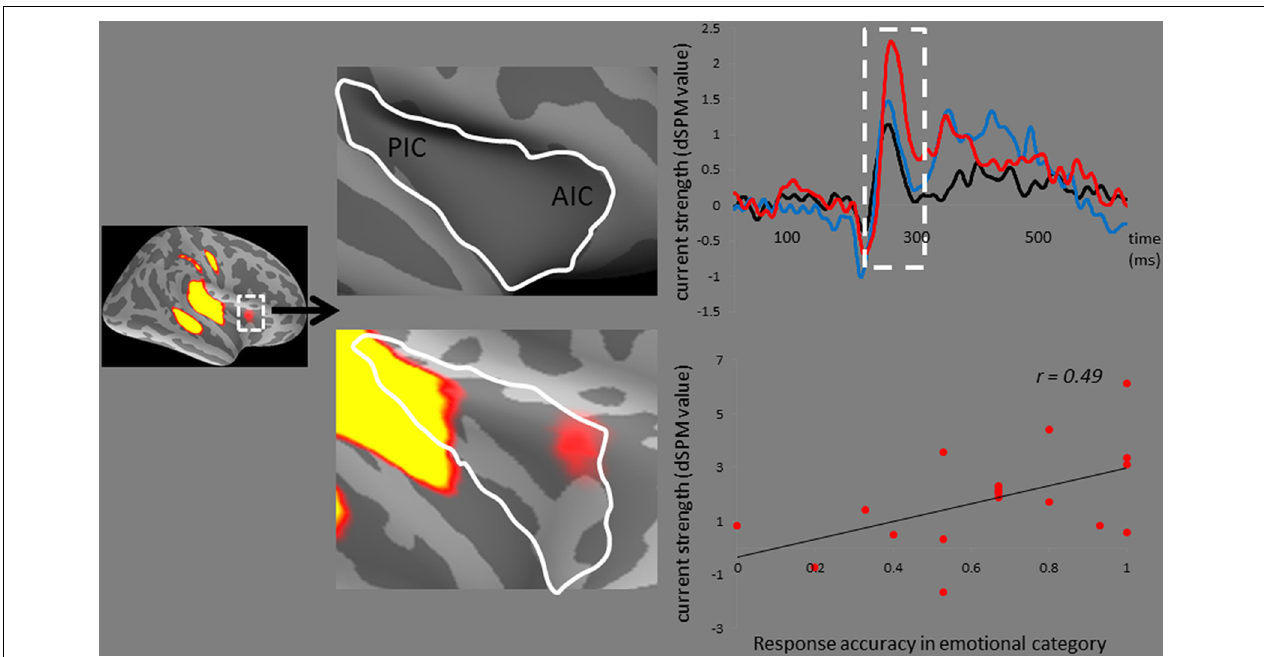
FIGURE 5 | The anterior insular cortex activity in response to disgusted syllables. Disgusted deviants exclusively elicited the activation in the AIC, as indicated by MMNm-related cortical activities. Grand average ( n = 19 participants) time courses of the mean estimated current strength were